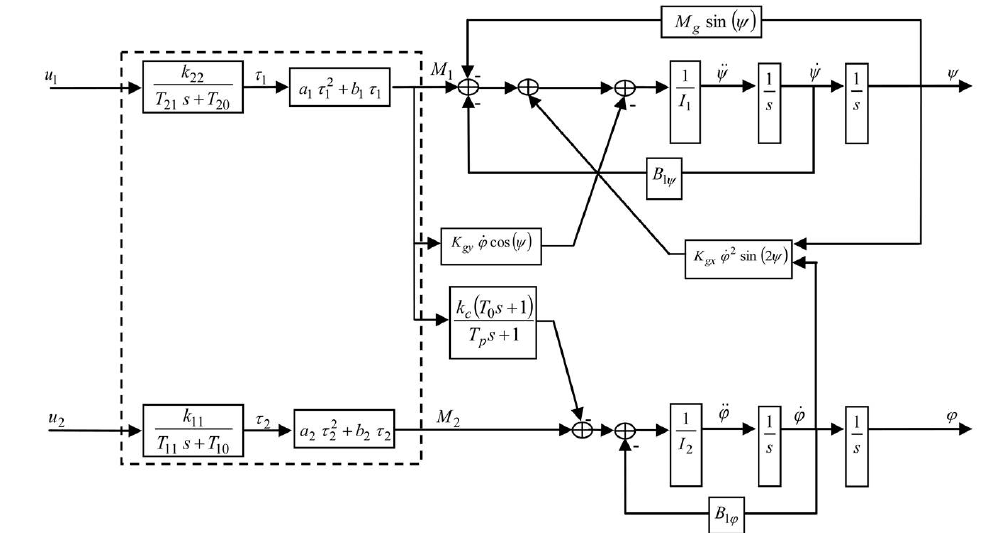
Figure 3. Block diagram of TRMS system.